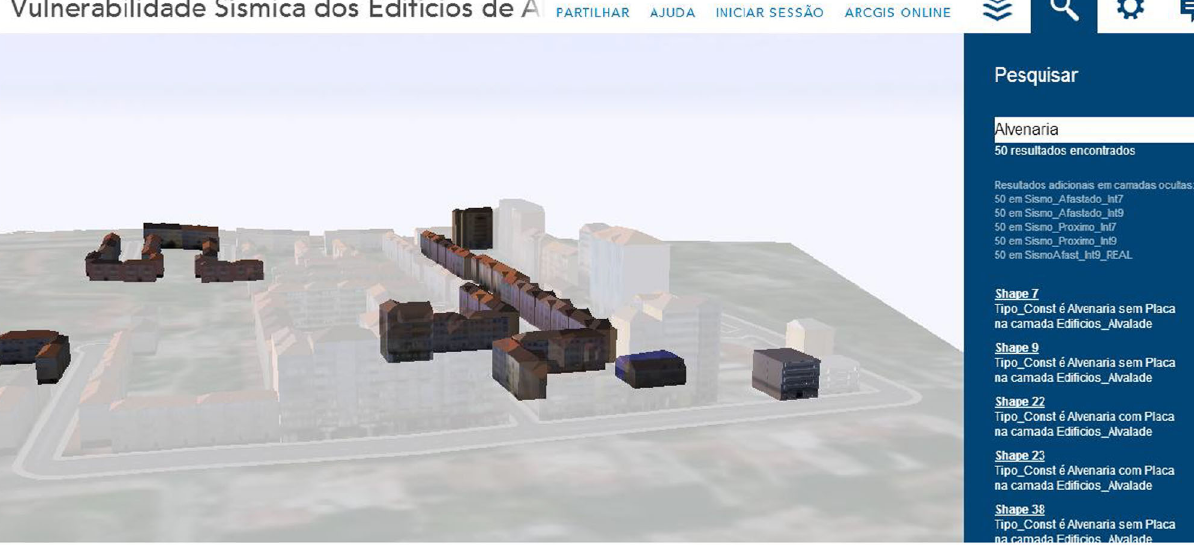
the criterion; (right) search criterion, amount of buildings matching the criterion (50), and respective list